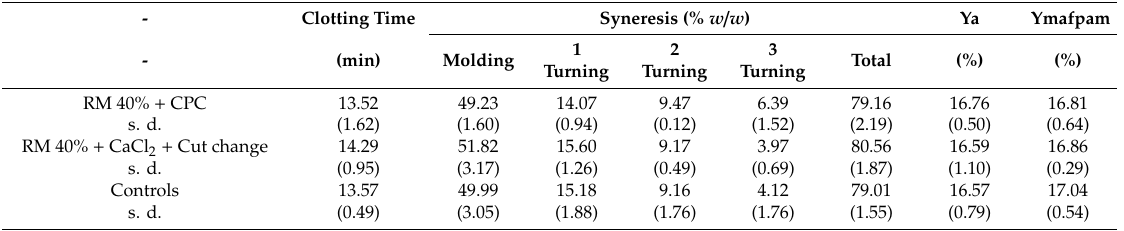
Table 4. Technological parameters determined in the Crescenza-type cheeses produced with 40% of recombined milk (RM) added with 0.5 mL / L CPC or with 0.05 g / L CaCl 2 followed by the cut change to reduce curd grain size; 100% fresh milk (control cheese). Clotting time, evolution of syneresis during processing, actual (Ya), and corrected (Ymafpam) cheese yields are